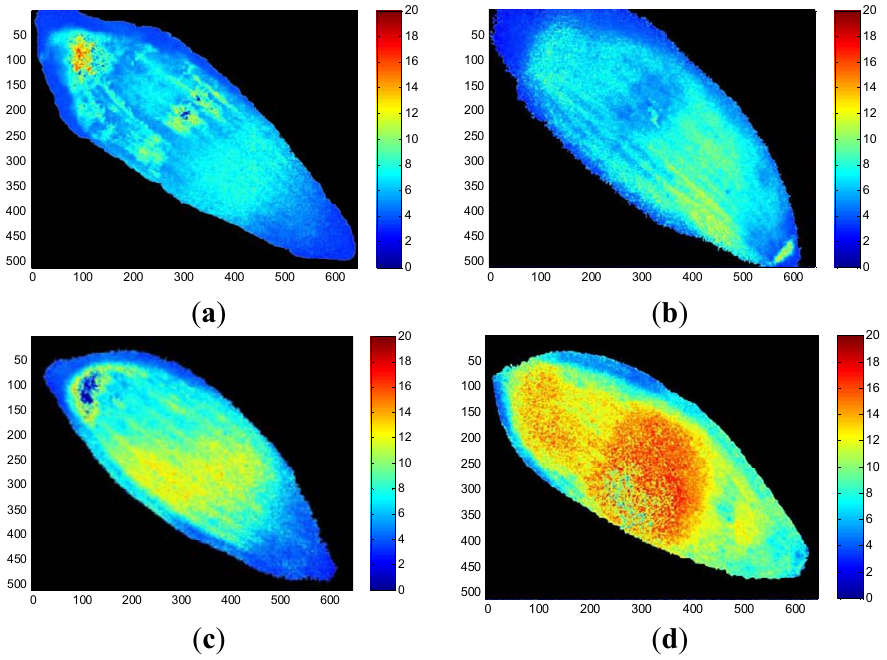
Figure 7. Thermal decay delay-time images of representative healthy seed ( a ) and seeds aged for 24 h ( b ), 48 h ( c ), and 72 h ( d ), produced using an exponential decay